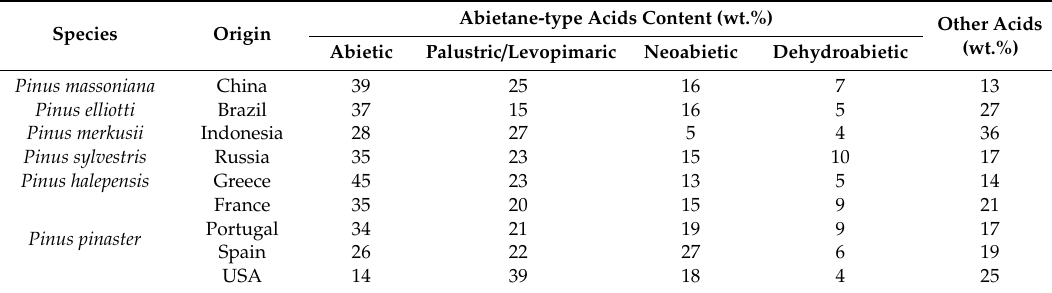
Scheme 1. Synthesis of essential rosin-based substrates / intermediates. Table 1. Composition of resin acids in gum rosin from di ff erent sources